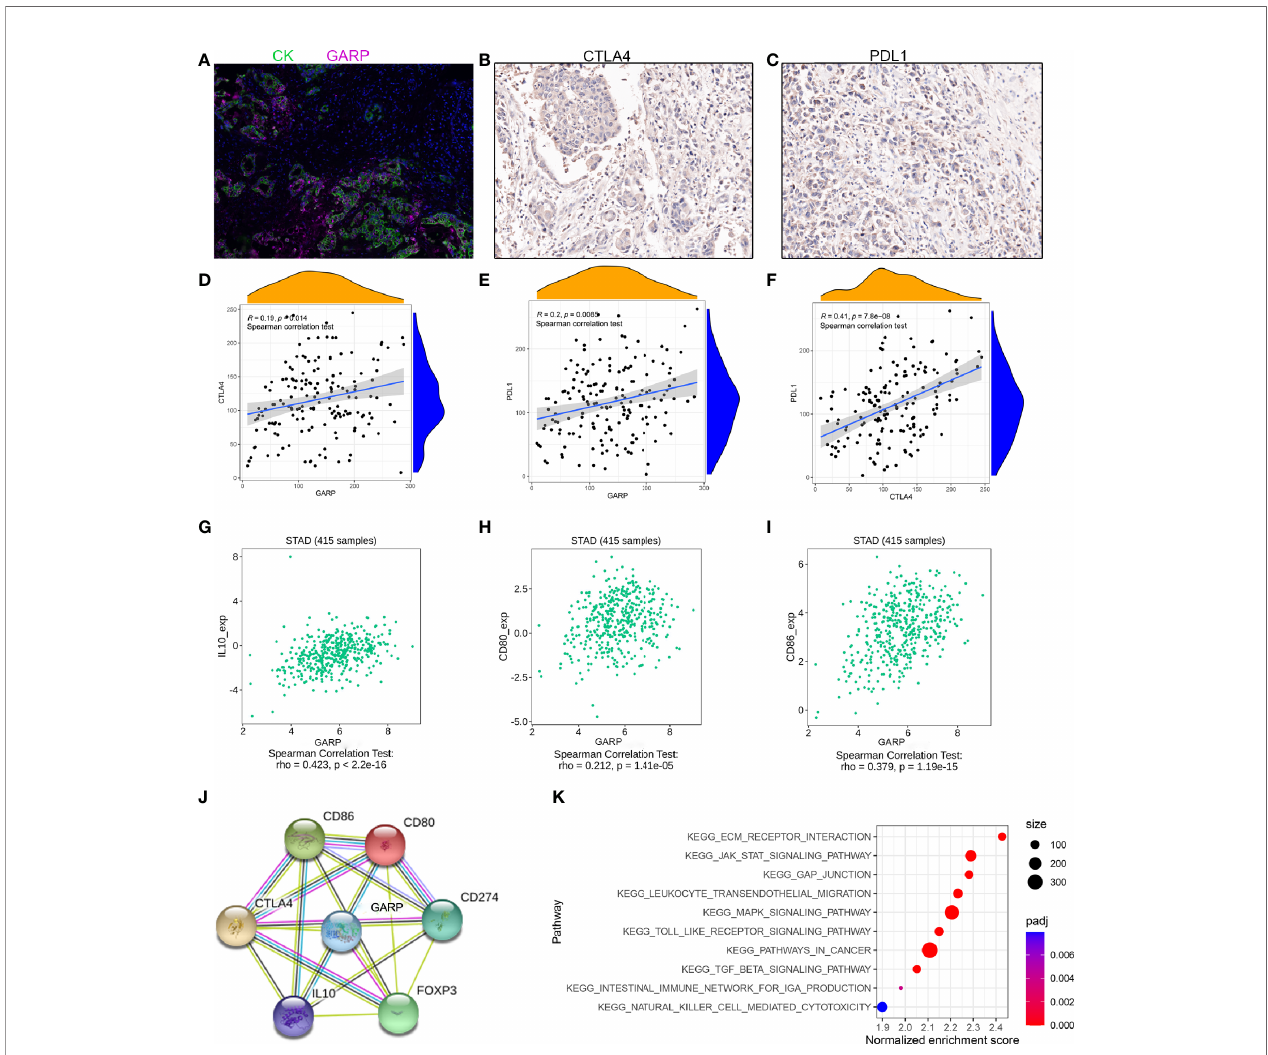
FIGURE 6 | (A – C) Representative images of GARP, PD-L1, and CTLA-4 staining in tissue microarray sections of tumor tissues. (D – F) The relationships between GARP and PD-L1 expression, GARP and CTLA-4 expression, and PD-L1 and CTLA-4 expression. (G – I) GARP expression was correlated with CD80, CD86, and IL-10 expression in the TISIDB database. (J) Protein interaction network in the STRING online database. CD274: PD-L1. (K) KEGG pathway analysis revealed 10 positively correlated